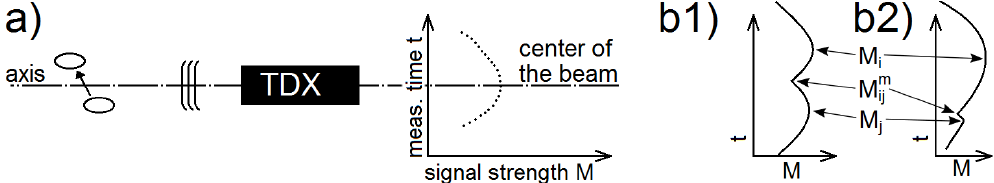
Figure 3. The signal strength was used to divide trajectories: ( a ) The typical signal strength of a bubble passing the beam axis. ( b1 ) The signal strength for two connected bubbles had two clear peaks. ( b2 ) The signal strength for one bubble with a noise. TDX: ultrasonic